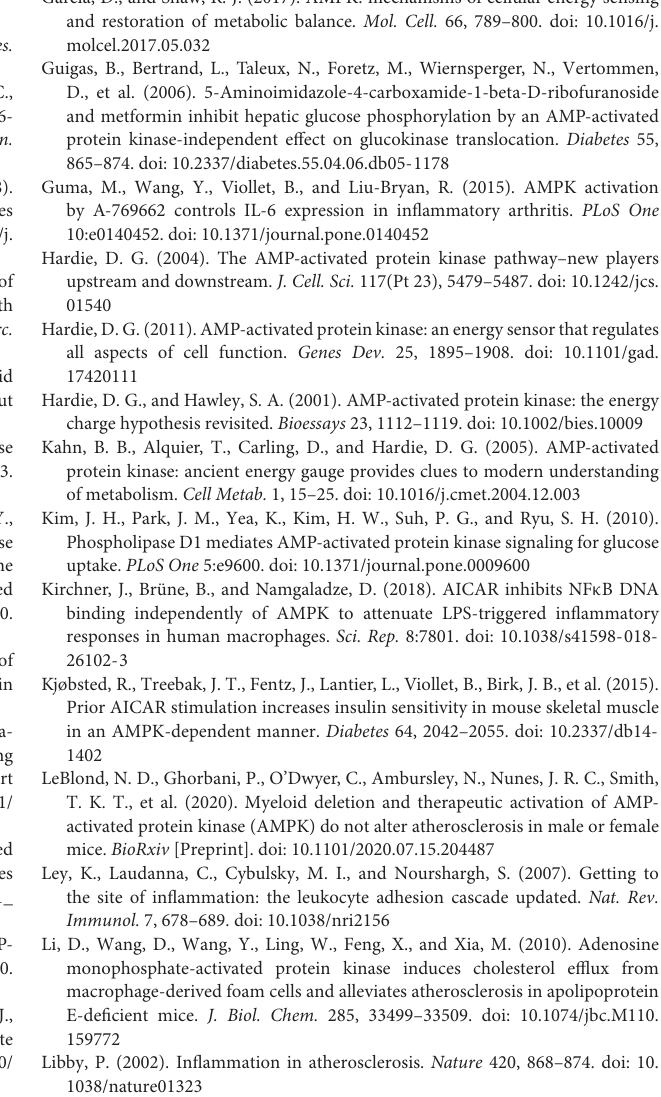
Supplementary Figure 6 | Hemavet data analysis of white blood cells (WBC), neutrophils (NE), leukocytes (LY) and monocytes (MO) from Apoe − / − / Prkaa1 WT (female, n = 13; male, n = 15), Apoe − / − / Prkaa1 (cid:49) M ϕ (female, n = 14; male, n = 11) mice fed Western diet for 16 weeks. All data are expressed as mean ± SEM. Statistical significance was determined by unpaired Student’s t -test. ∗ p <